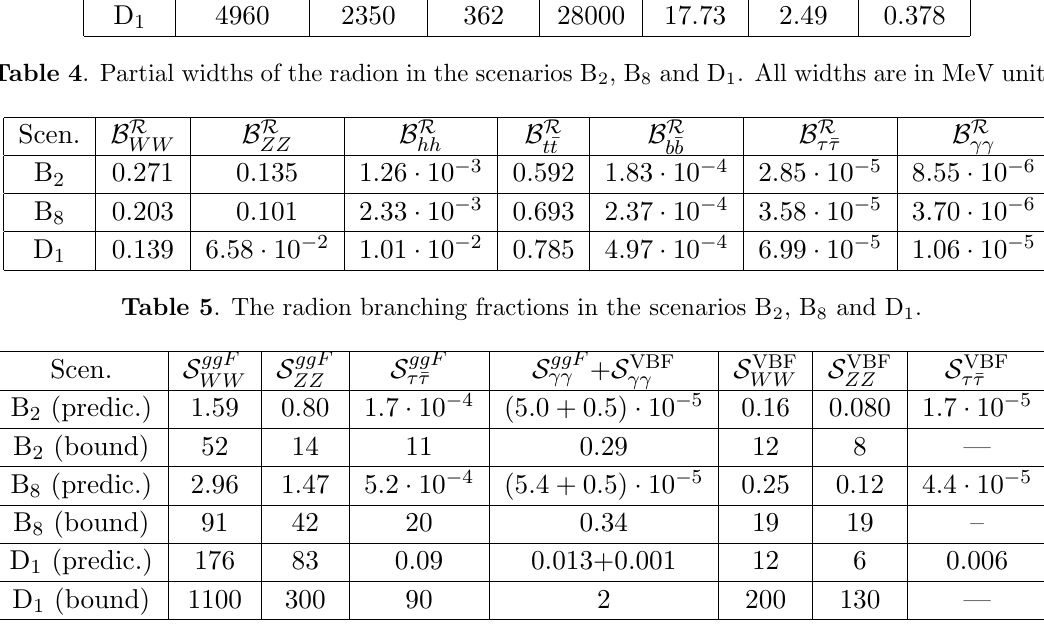
D (predic.) 1 Table 6 . The predictions of S ggF ( V BF ) and their corresponding 95% C.L. upper bounds in the sce- XX narios B 2 , B 8 and D 1 . The bound on the (cid:13)(cid:13) channel does not distinguish between gluon and vector fusion production and then has to be compared to the sum of the two processes. No speci(cid:12)c